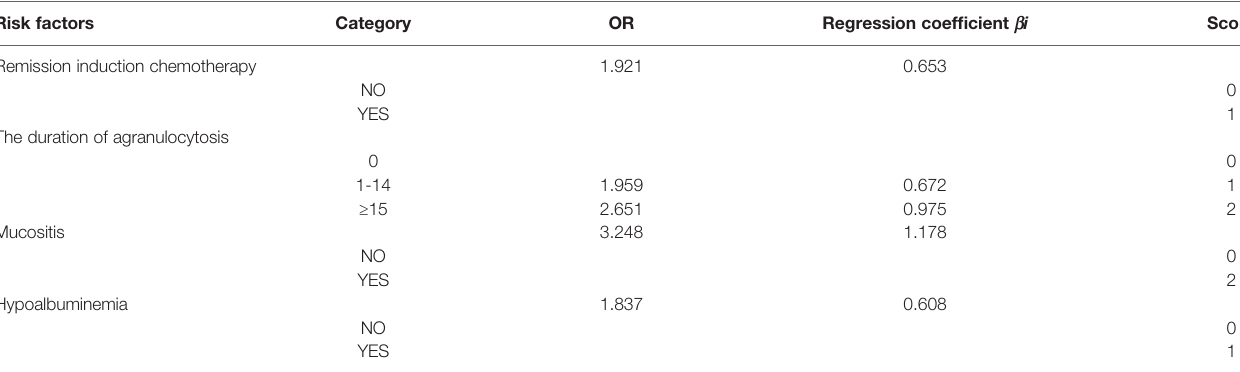
TABLE 3 | Predictive scoring table for risk of subsequent infection after CR-GNB colonization in HM